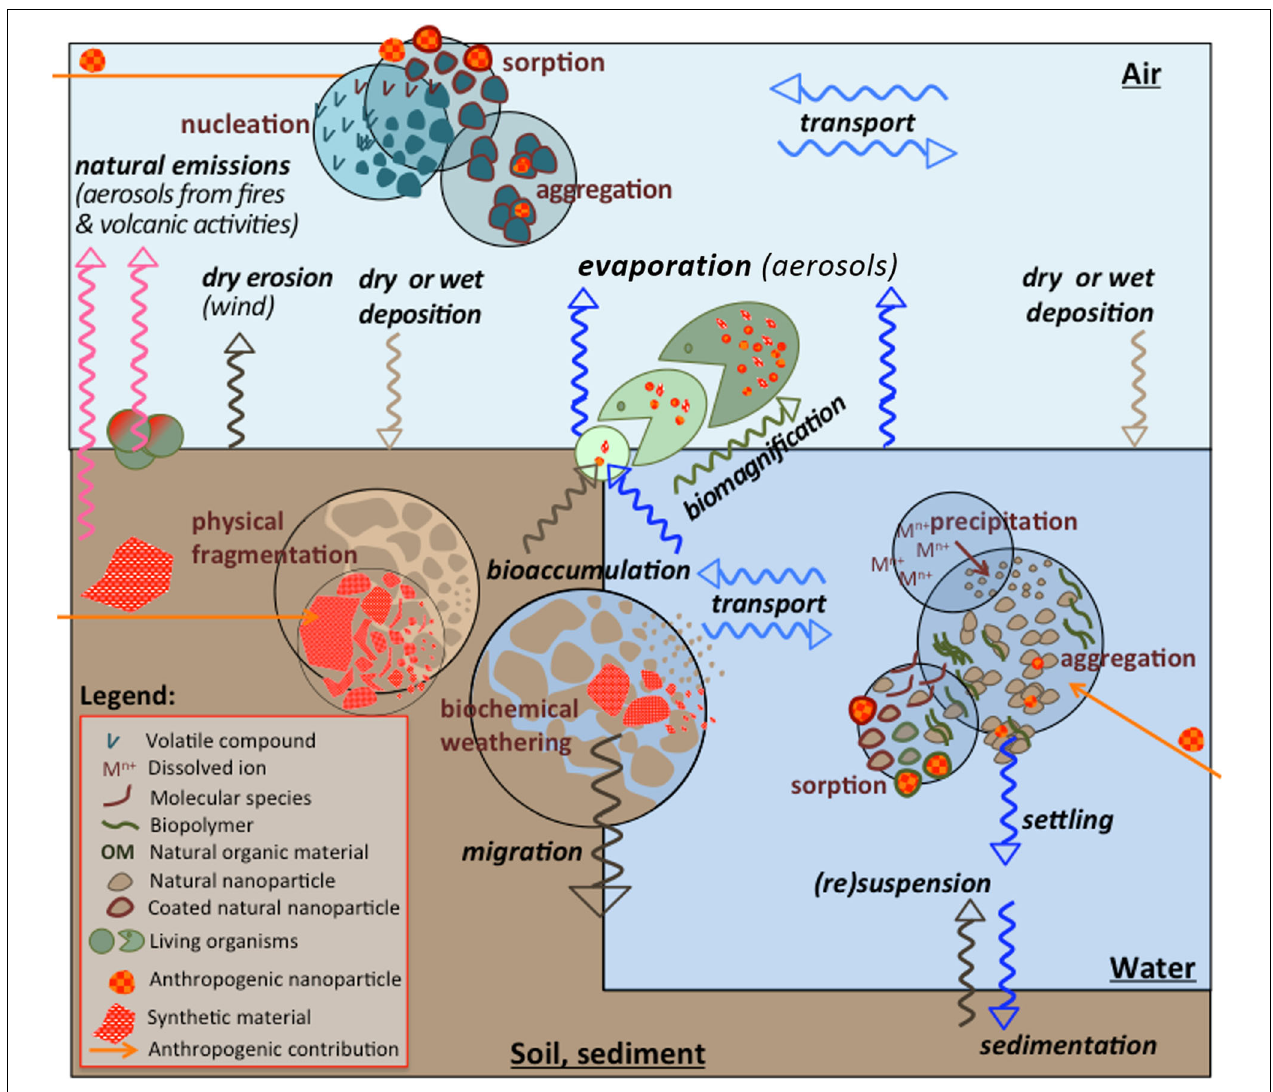
FIGURE 1 | Nano-sized particles in the environmental compartments. Processes governing their distribution among environmental compartments (in italic), their formation, and their transformation (in circles) are highlighted. ANPs (in red) originating from macroscopic or nanomaterials, once released into the environment take part in the same distribution and transformation